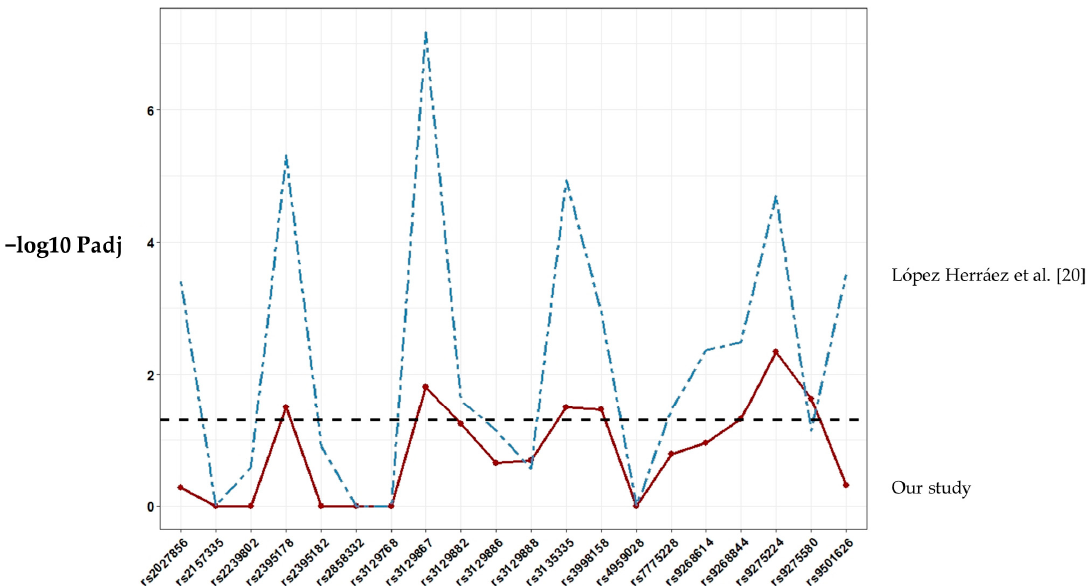
Figure 1. Association results for SNP markers within the HLA region included in this study. The score of the − log10 Padj values for each SNP association is shown as a continuous line plot. Abbreviations: Padj, p -value using Bonferroni correction.